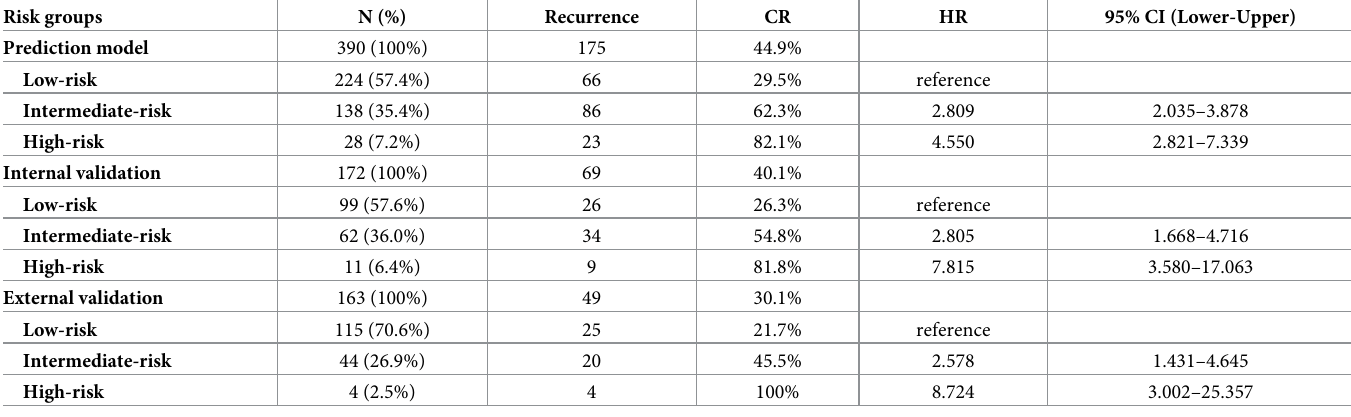
Table 3. PI-based Kaplan–Meier analysis and univariate Cox regression analysis in the model and